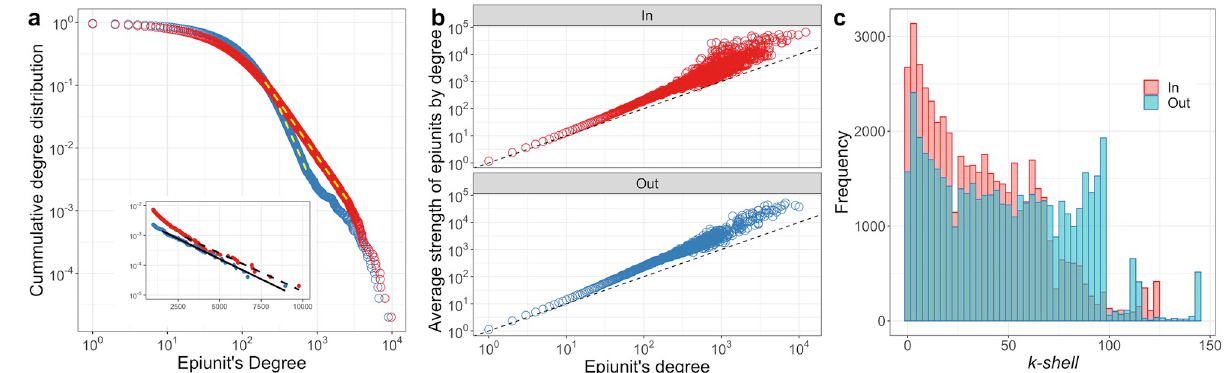
Fig 2. a . Log-Log plot of the complement of the cumulative distribution of in (red) and out (blue) degrees. Yellow dashed lines show the scale-free region of in/out degree. The inset shows the exponential decay of the tail for both distributions and the exponential fit. b . Average strength � s ð k Þ of epiunits with degree k for in/out degree/strength, as indicated in panels. Dashed line indicates s i = k i c . Frequency of epiunits in each (in—red/out— blue) k -shell in the network.